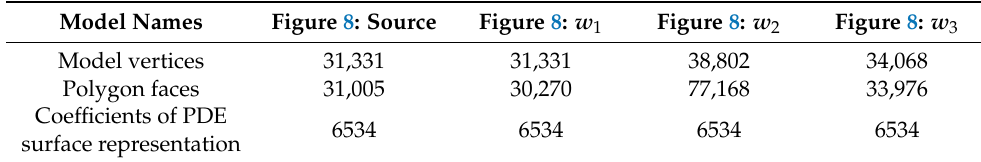
Table 1. Comparison of design variables between polygon models and their PDE surface representations. Model